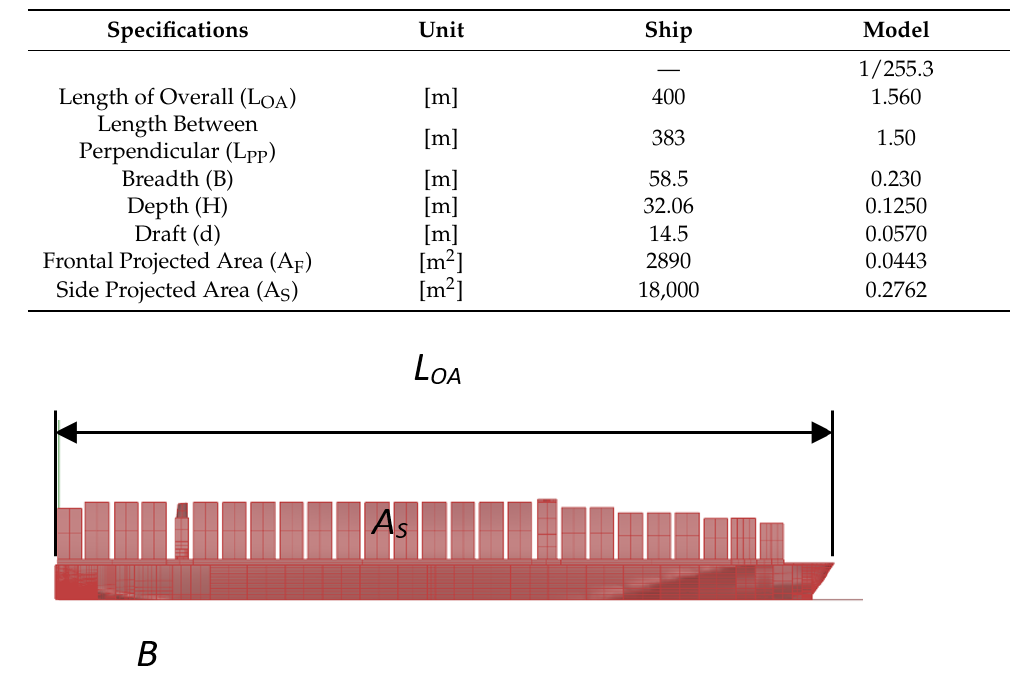
Table 1. Principal particulars of ship and model.